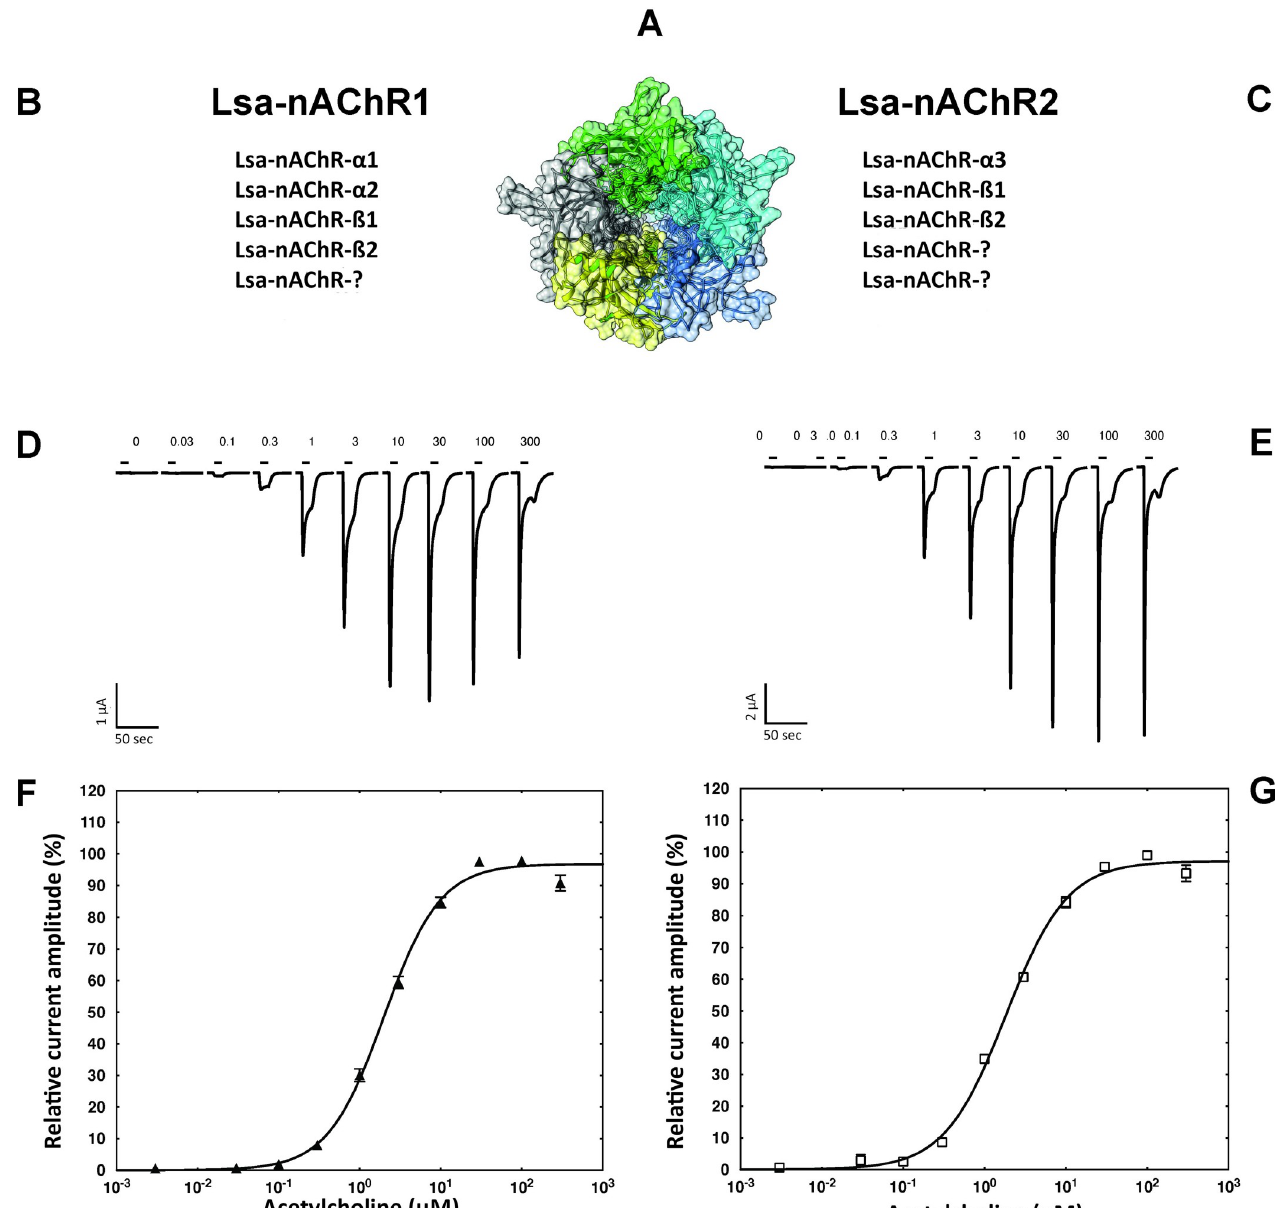
Fig 3. Hypothetical stoichiometry, current traces and dose response curves of L . salmonis nAChRs. Hypothetical 3D model of a Lsa-nAChR (A ). Subunits composition as well as current traces and averaged dose response curves from a cumulative exposure to increasing dosage of acetylcholine (in μ M) for Lsa- nAChR-1 ( B, D and F ) and Lsa-nAChR-2 ( C, E and G ) are shown. Individual curves were standardized to the fitted maximal current amplitude and subsequently averaged. Mean ± SEM of experiments carried out with at least six oocytes from two batches is shown. For both receptors, the exact stoichiometry is not known yet and the precise relative positioning of each subunit remains to be determined. The question marks ( B and C ) represent copies of one of the subunits already indicated. At high ACh concentration (300 μ M; D and E ), an open channel block is visible (smaller currents than at 100 μ M) as well as bounce back current when the agonist is removed (relief from the agonist